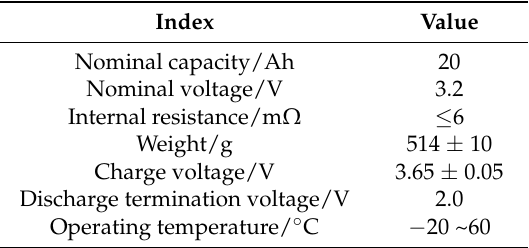
Table 2. Basic parameters of a lithium iron phosphate battery.